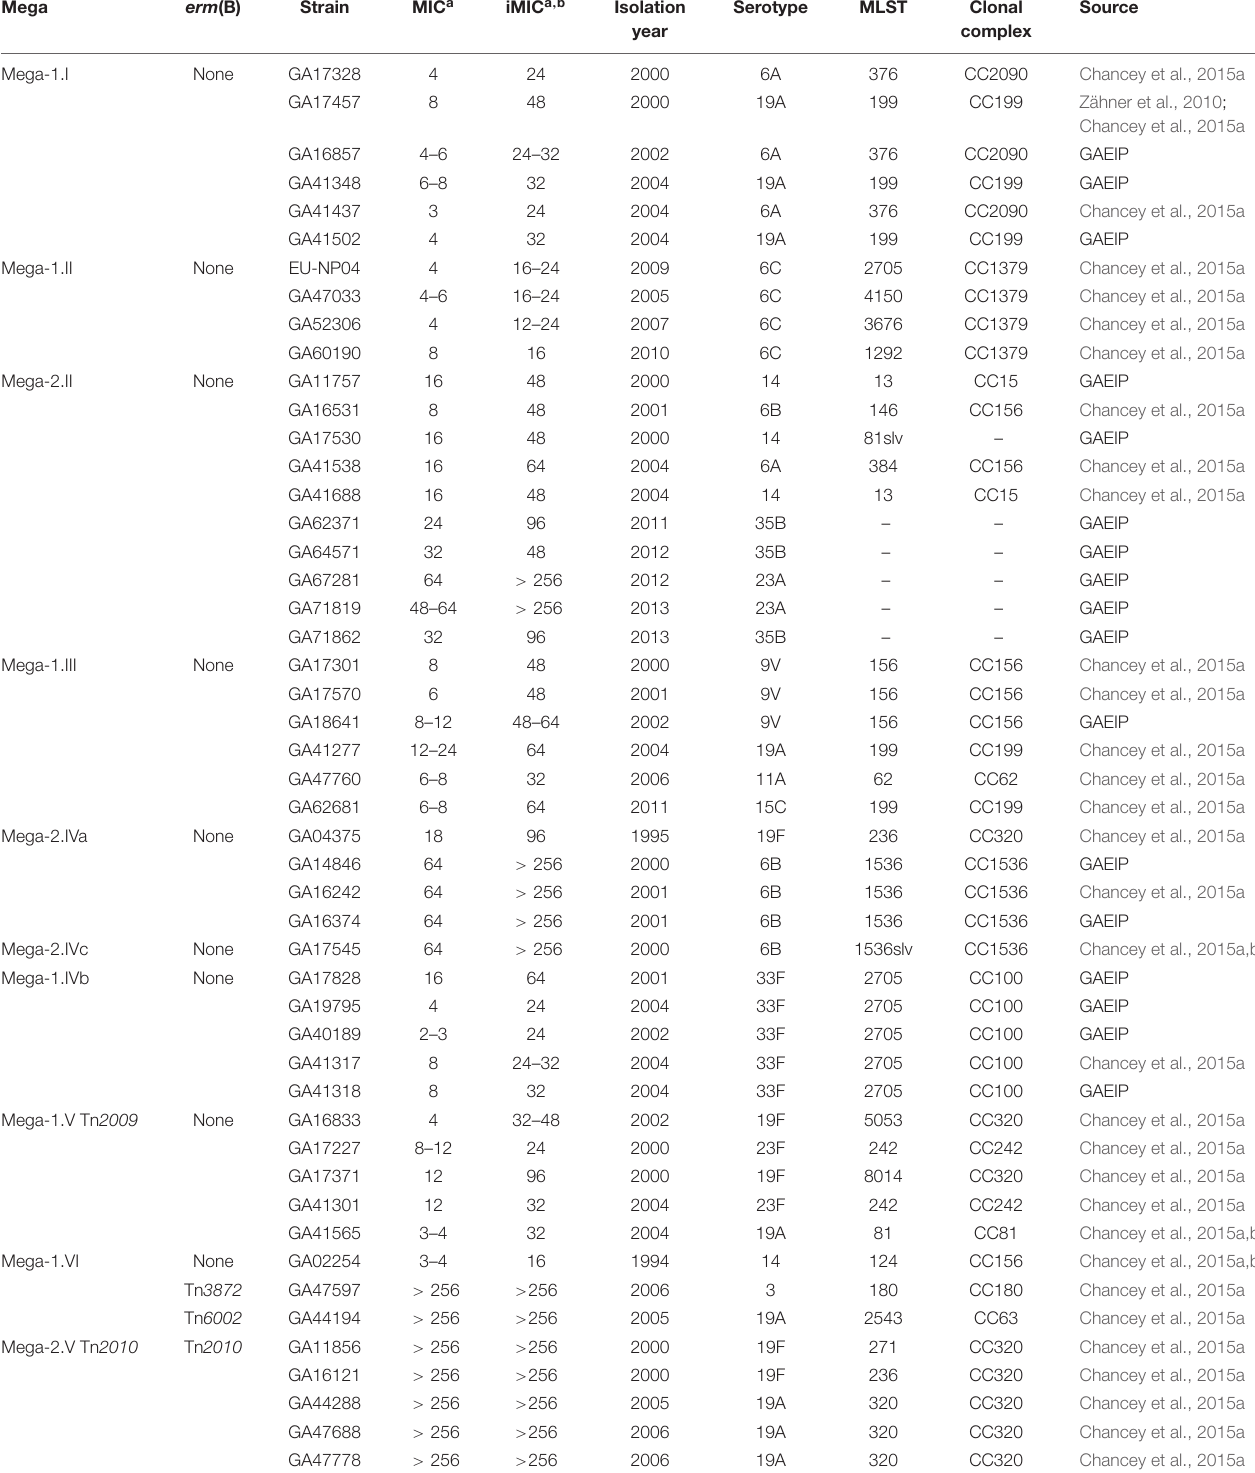
TABLE 1 | S. pneumoniae isolates (including isolation year, serotype, MLST, clonal complex, and source) with Mega (genetic insertion site), erm (B), or both, and minimum inhibitory concentrations (MICs) to erythromycin.